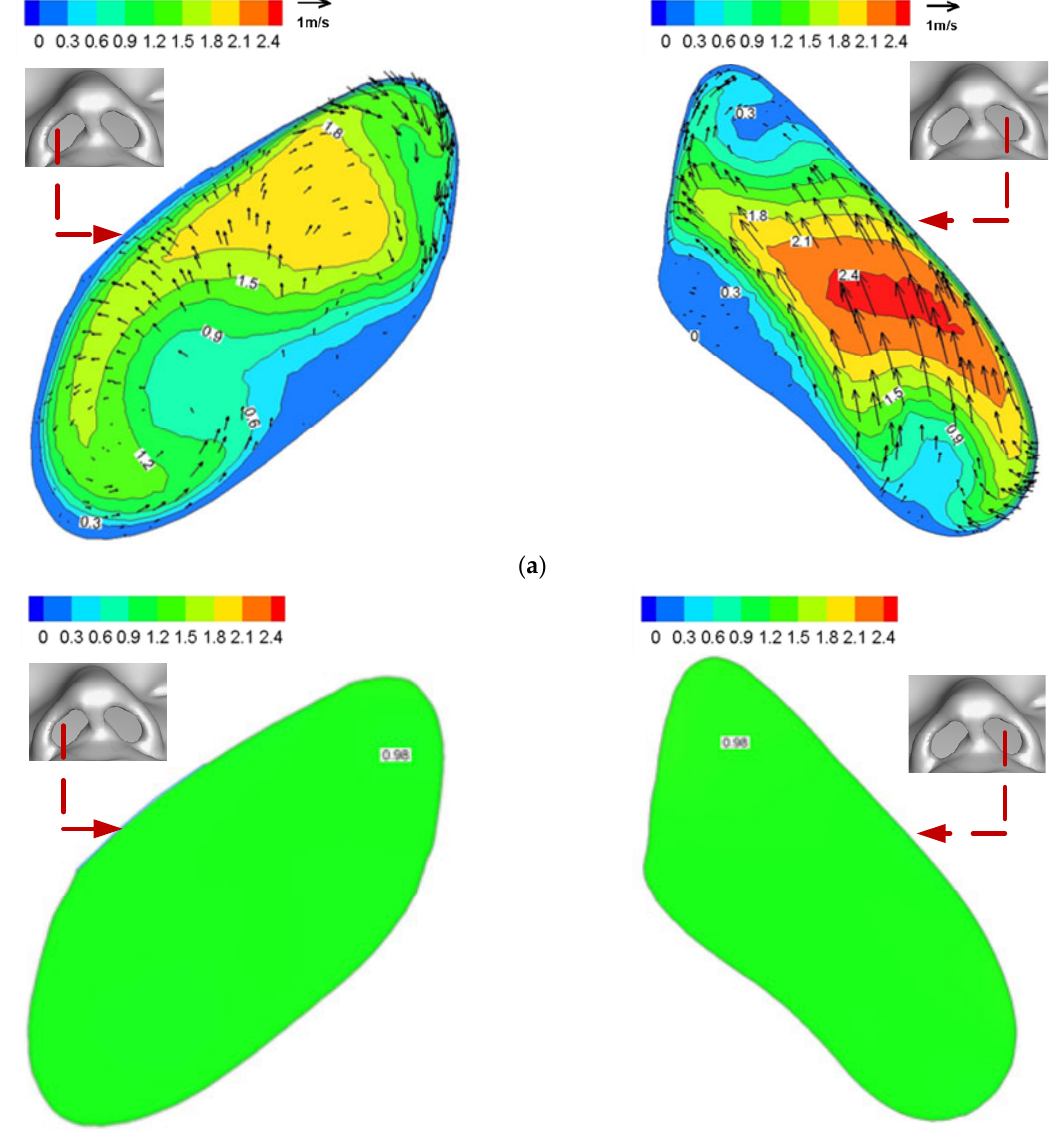
Figure 4. Nebulogram and tangent vector diagram of velocity distribution at nostril: ( a ) V in = 1 m/s, T = 291 K, CA; ( b ) V in = 1 m/s, T = 291 K, NCA.